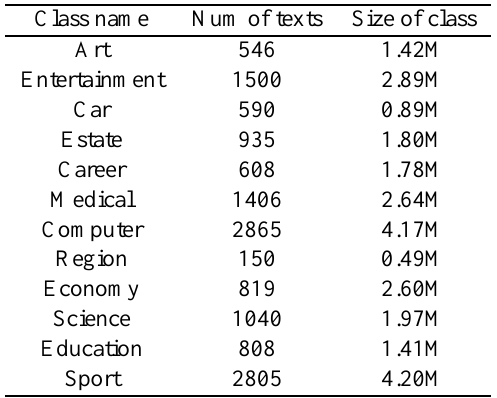
Table 2. Distribution of TanCorp-12 (M= megabyte).